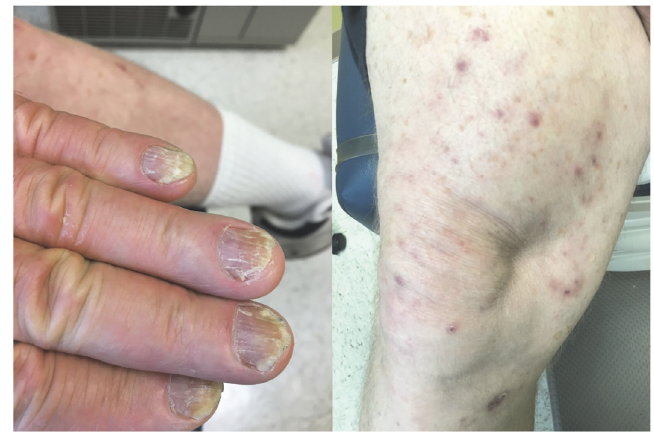
Figure 1: Dystrophic nail findings and circular purple papules on patient’s lower extremity prior to therapy.